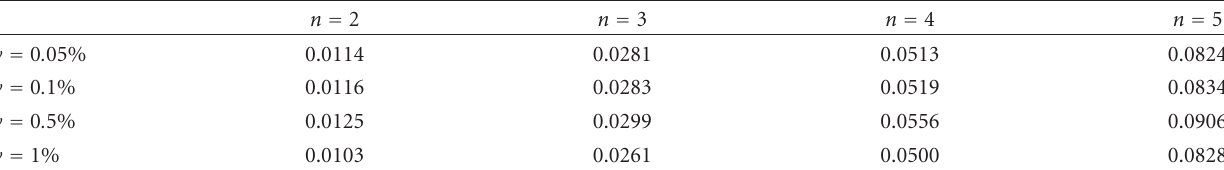
Table 3: Relative error between frequency shifts relevant to the imperfect rotor, evaluated according to the HOM model and the EB model. The imperfection is introduced by increasing the mass of the fourth blade of the perfect rotor described in Section 4.1 by γ = 0 . 05%, 0 . 1%, 0 . 5%, and 1%, with respect to its nominal value. Modal frequencies relevant to modal numbers n = 2 · · · 5 and l =